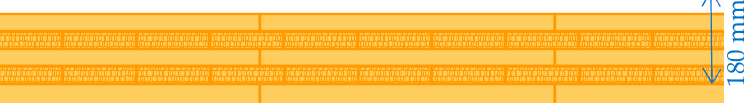
Figure 3. Configuration 1: Bare floor.